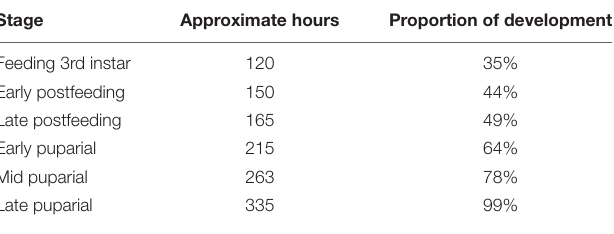
validation in Chrysomya rufifacies reared at 25 ◦